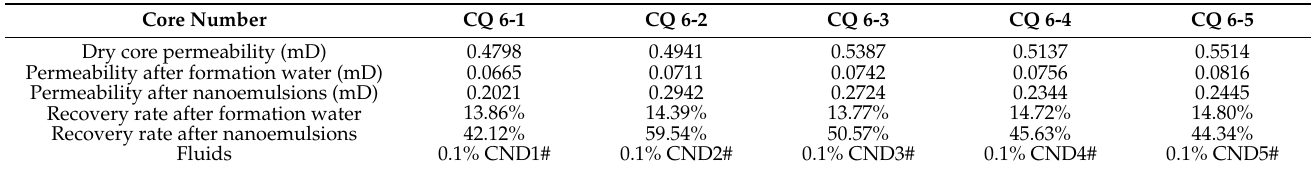
Table 5. Permeability recovery values of cores treated by different